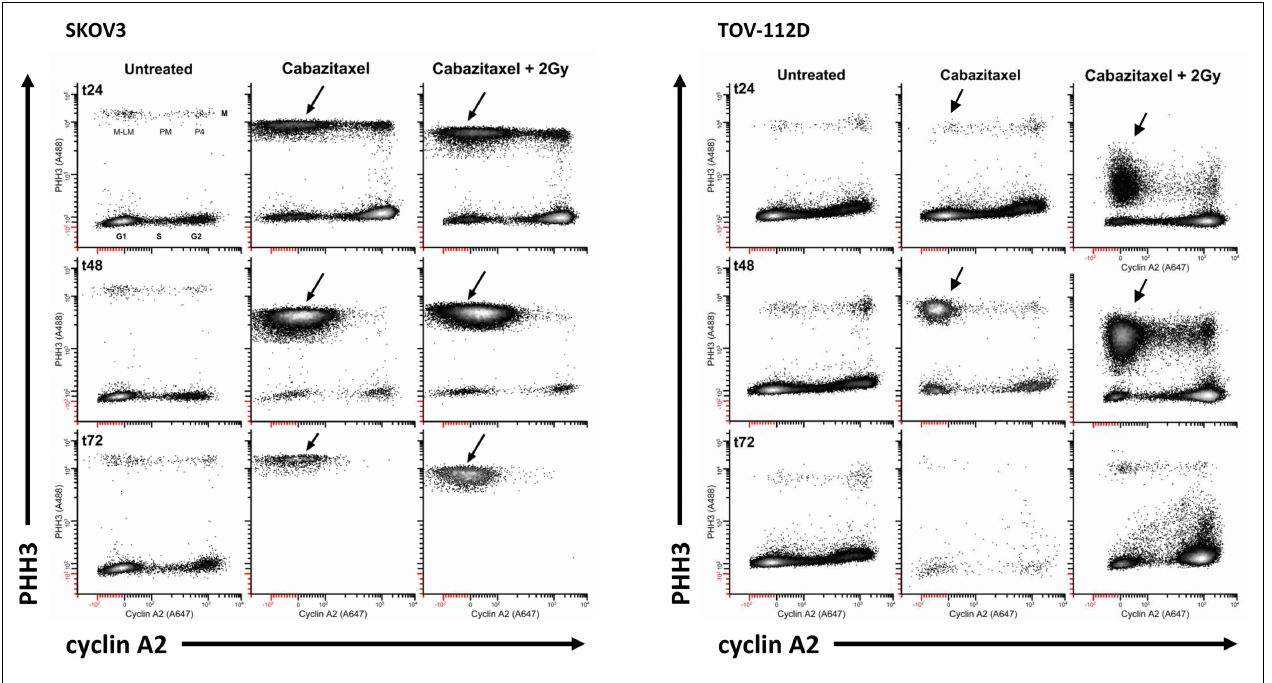
Plots are PHH3 (phospho-S10-histone H3) versus cyclin A2. Mitotic cells have elevated PHH3 and three mitotic states can be quantified (P4, PM, M-LM).These are named as previously described (42). Arrows point out